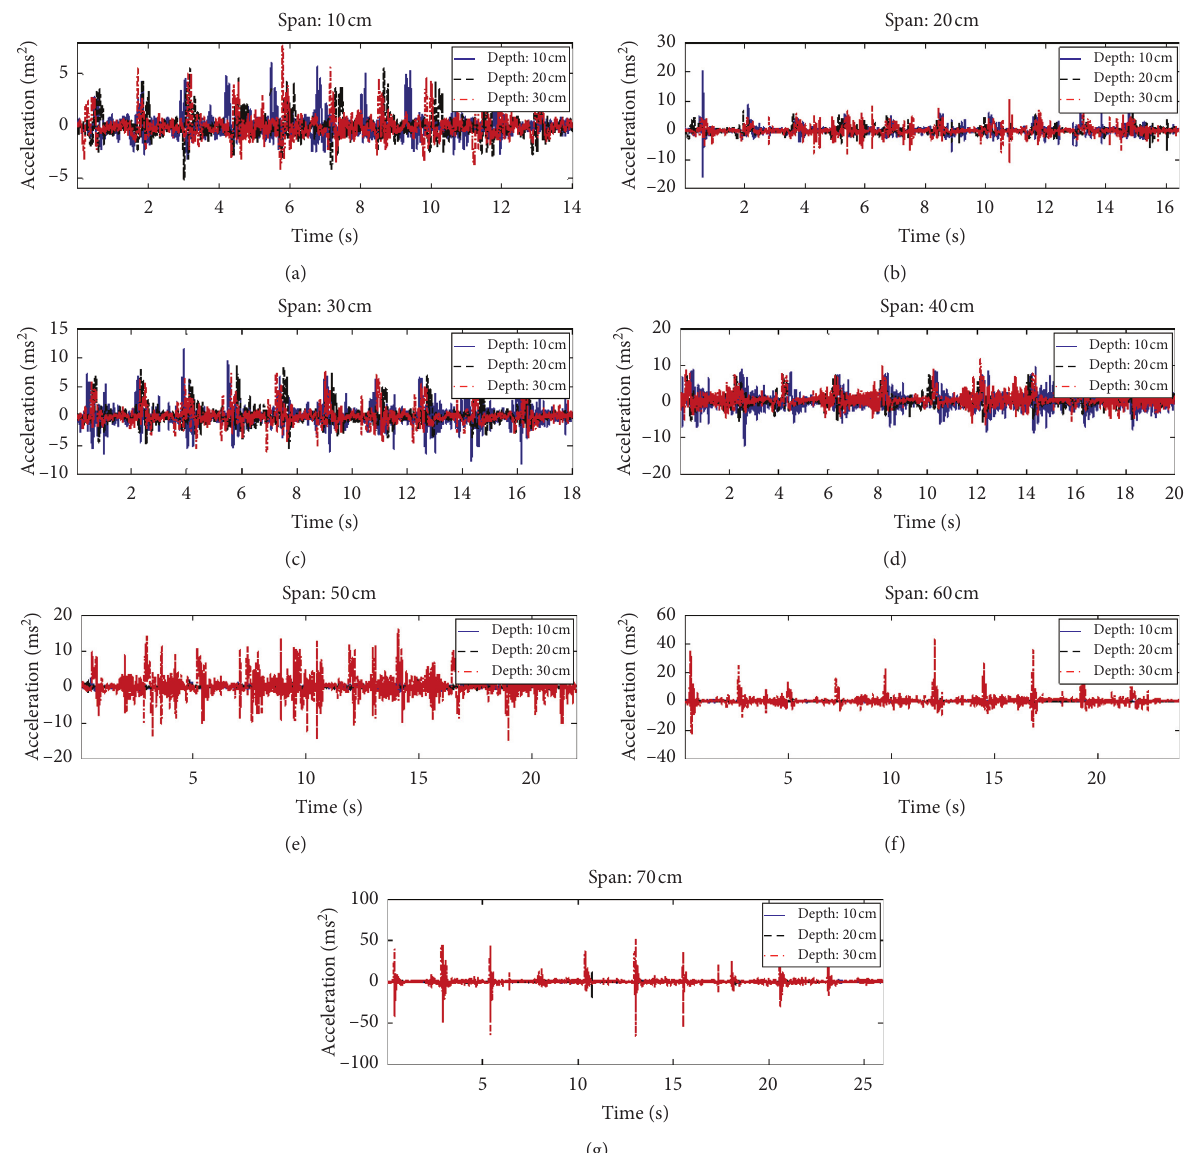
Figure 6: Time-domain diagram of the vibration acceleration